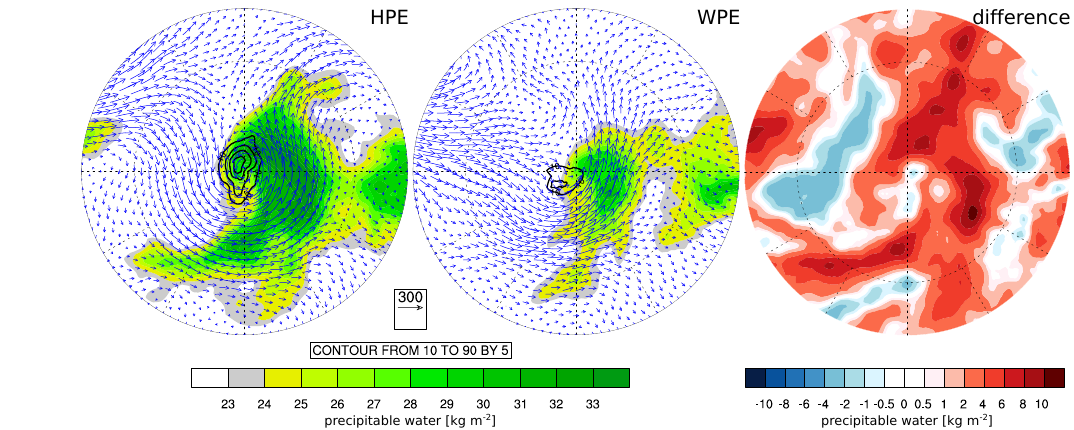
Figure 6. Composites of precipitable water content [kgm − 2 , shading] and precipitation amounts (black contours) for the HPEs (left panel) and for the WPEs (centre panel). Additionally the moisture flux is shown by arrows integrated over the vertical structure of the atmosphere (reference vector: 300kgm − 1 s − 1 ). The time step with maximum precipitation is shown for all variables. The distance from the centre of the composite cyclone to the edge is 23 ◦ . The difference in precipitable water between HPEs and WPEs is shown (right panel).